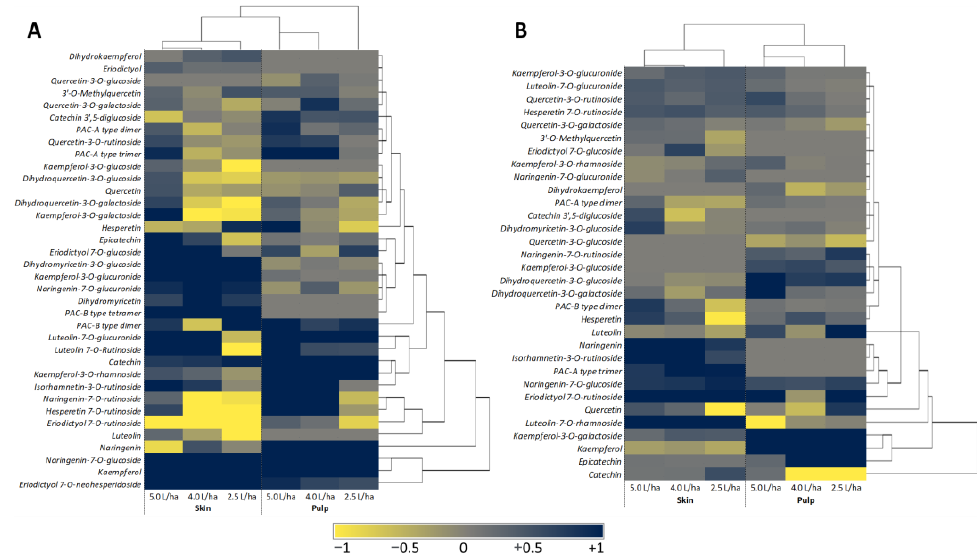
Figure 5. Heat map coupled to a heriodictal analysis showing the relative content of phytochemical compounds identified and quantified in the peel and pulp of peaches harvested from Prunus persica trees var. “Sugar Time” ( A ) or “West Rose” ( B ) treated with different concentrations (2.5, 4.0 or 5.0 L/ha) of biostimulant. The relative content was calculated as ln(treated samples/water-only samples), using the values reported in Tables 2 and 3. The different colors refer to the increase (blue) or decrease (yellow) in the respective molecule. The dendrogram represents the linkage clustering among the treatments (top) or phytochemical compounds (right) using Euclidean distance measures.